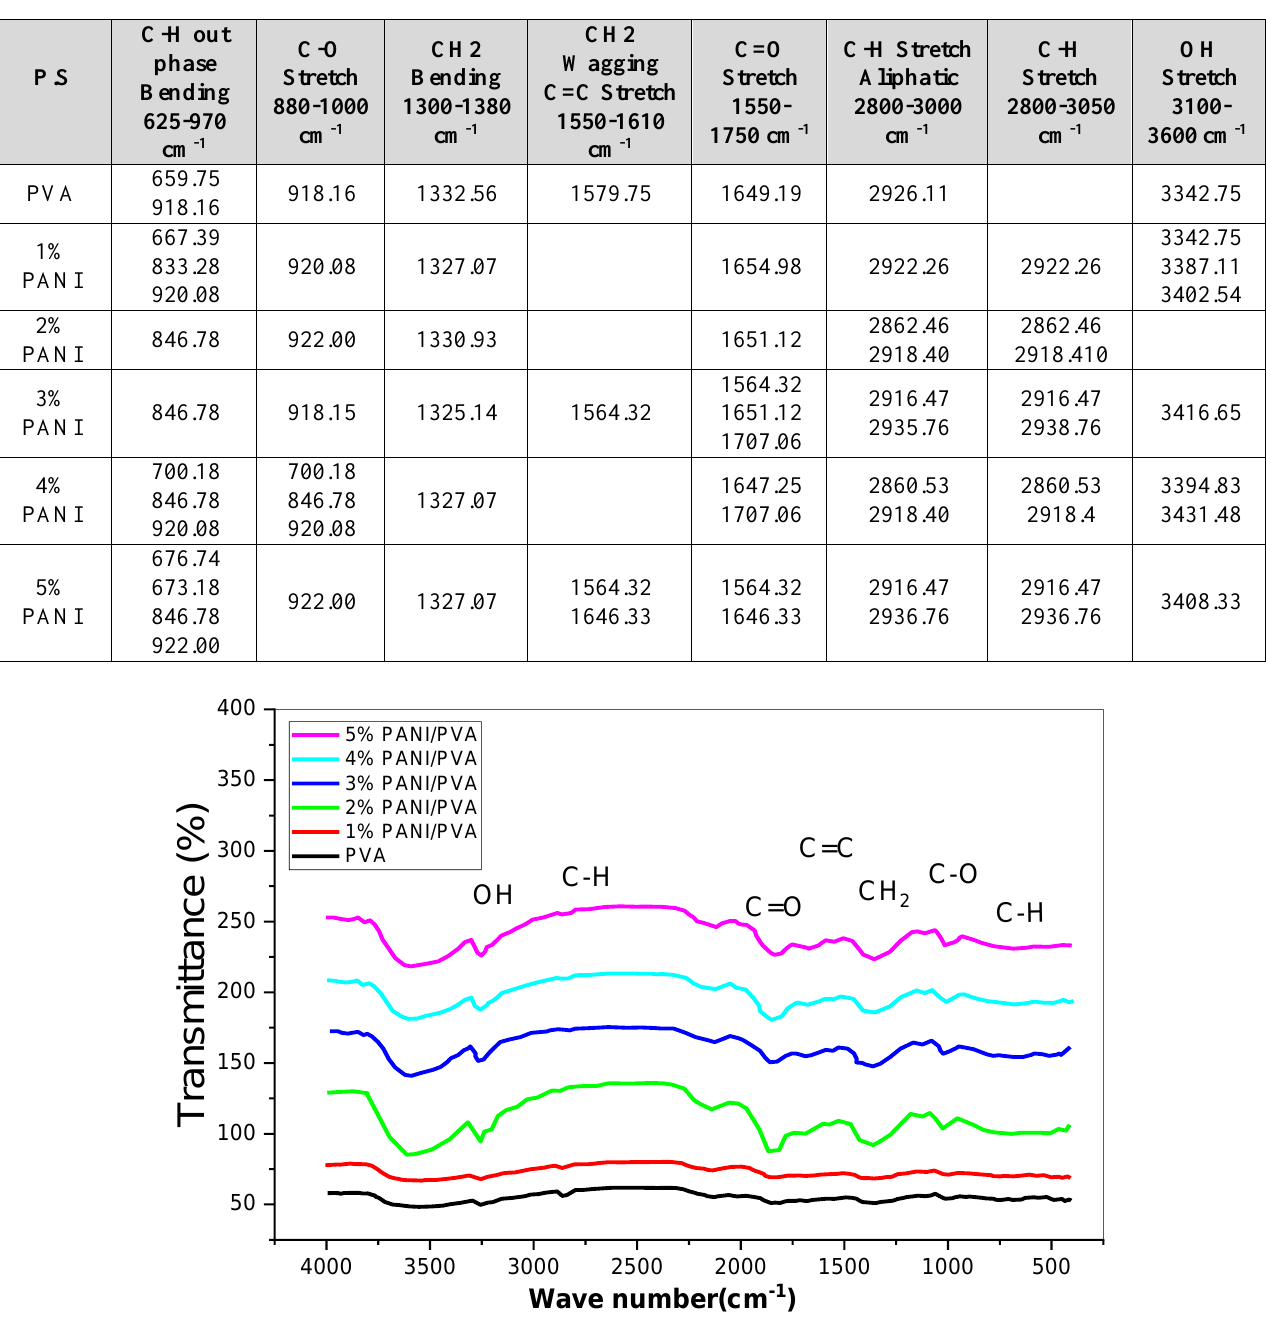
Table 1: FTIR characteristic of PVA before and after PANI addition at different ratios.